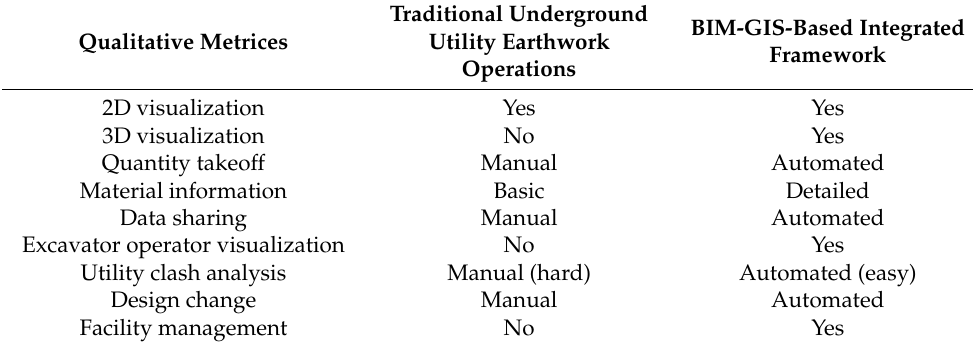
Table 2. Qualitative evaluation of BIM-GIS-based underground utility management system. Traditional Underground Qualitative Metrices